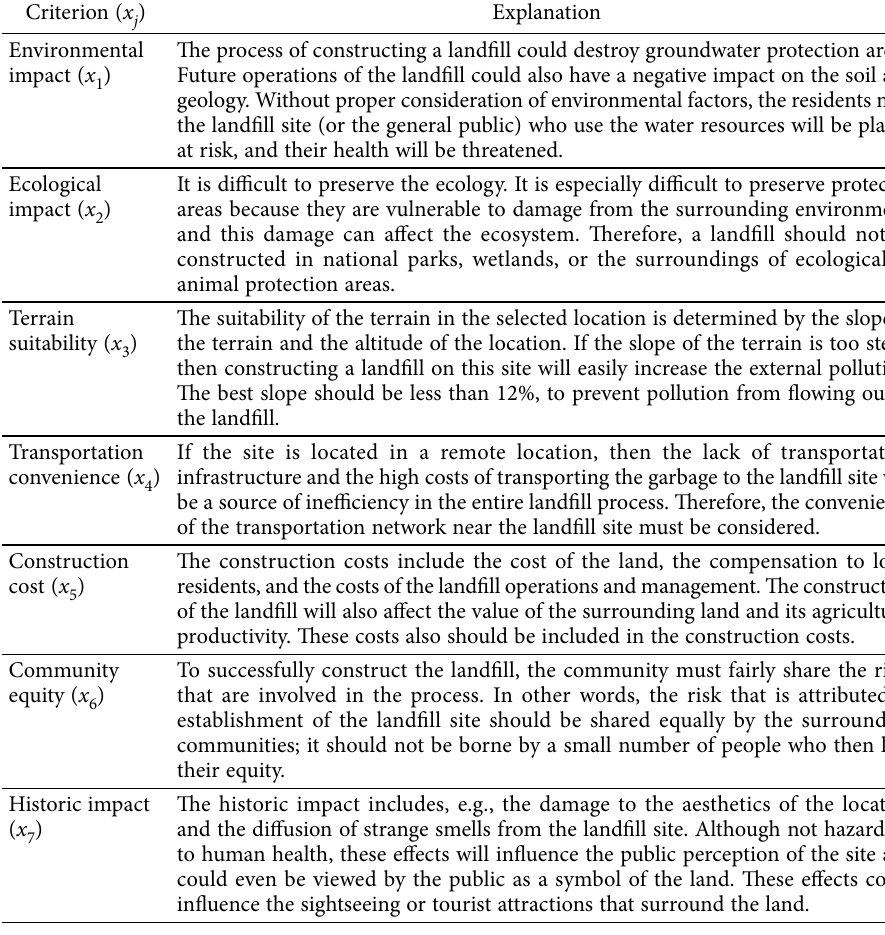
Table 2. Criteria used to evaluate the landfill